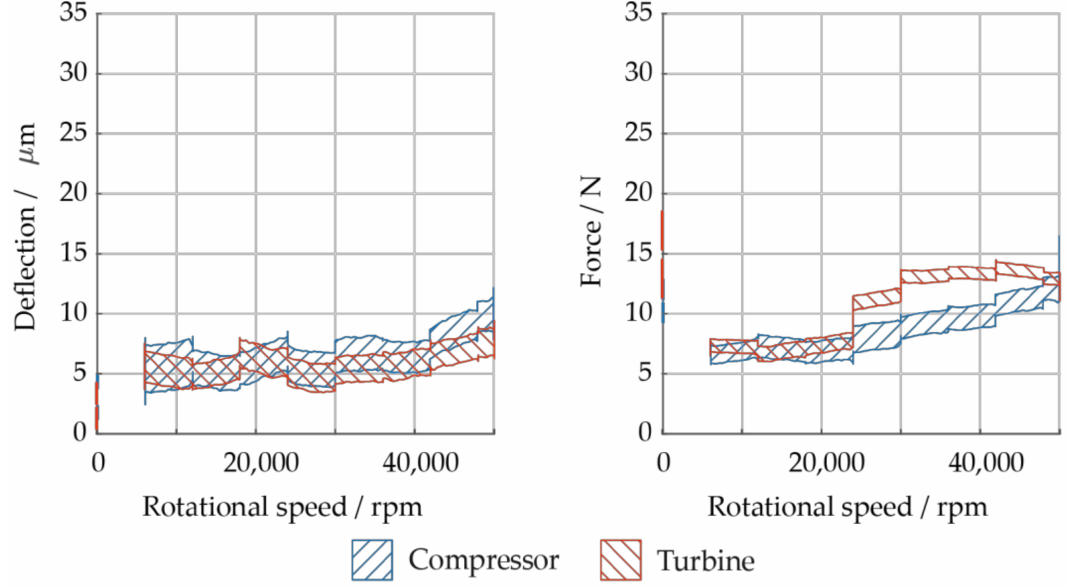
Figure 7. Deflection and forces at radial bearings on compressor and turbine side during air pre-tests for speeds ranging from 0 rpm to 50,000